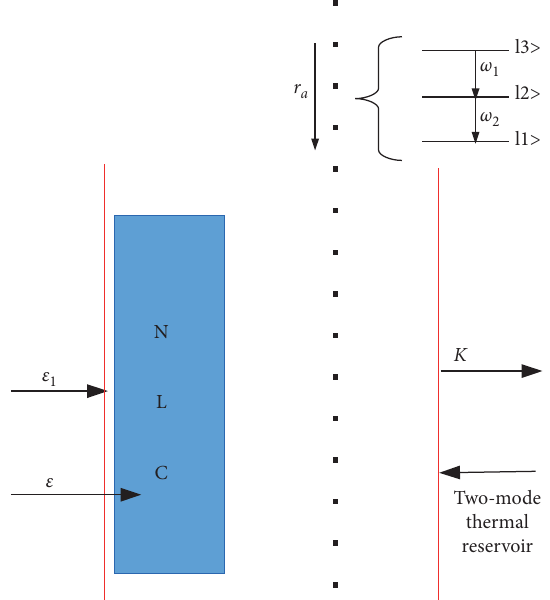
Figure 1: Schematic representation of a two-mode three-level cascade laser coupled with a two-mode thermal